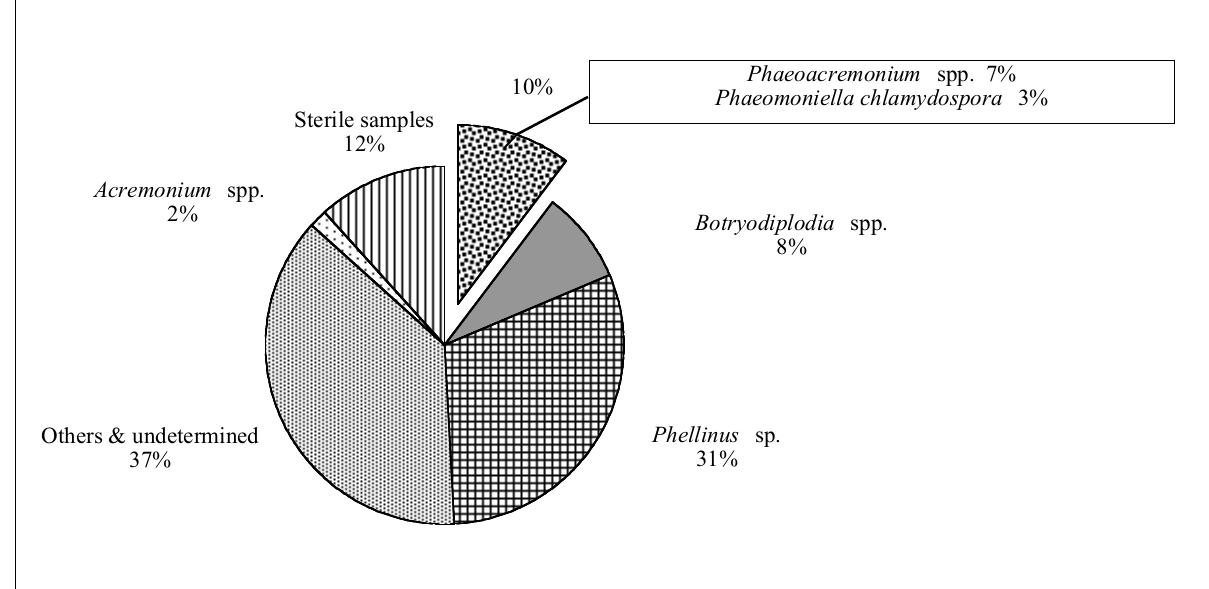
Fig. 1. Percentage of Phaeoacremonium species and Phaeomoniella chlamydospora out of the total microflora isolat- ed from mature vines showing hoja de malvón